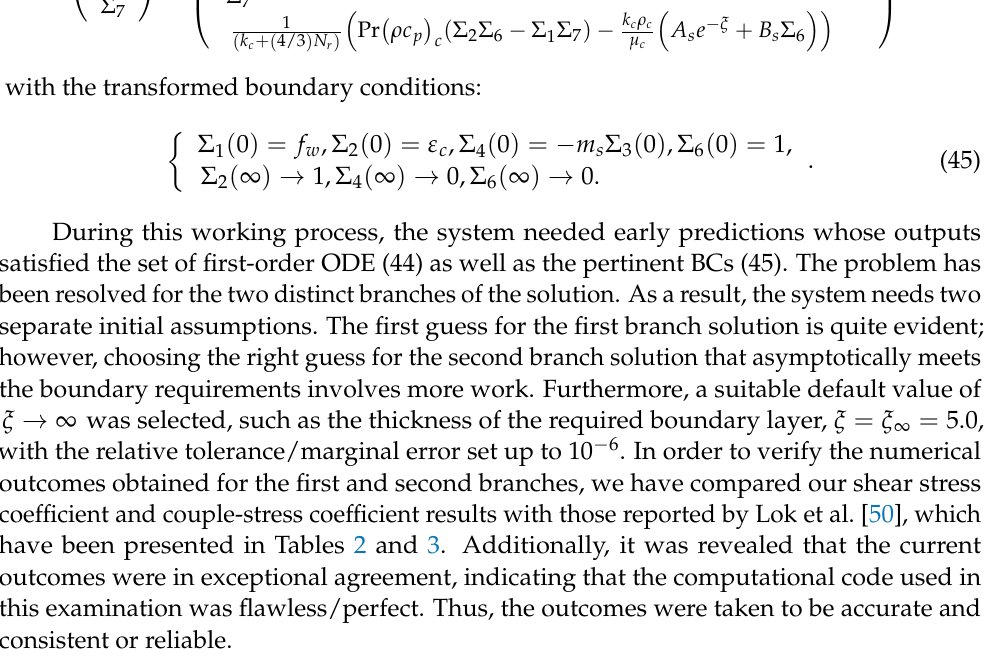
Table 2. Values of shear stress for the several values of γ c and K c when ε c = 0, f w = 0, ϕ 1 =